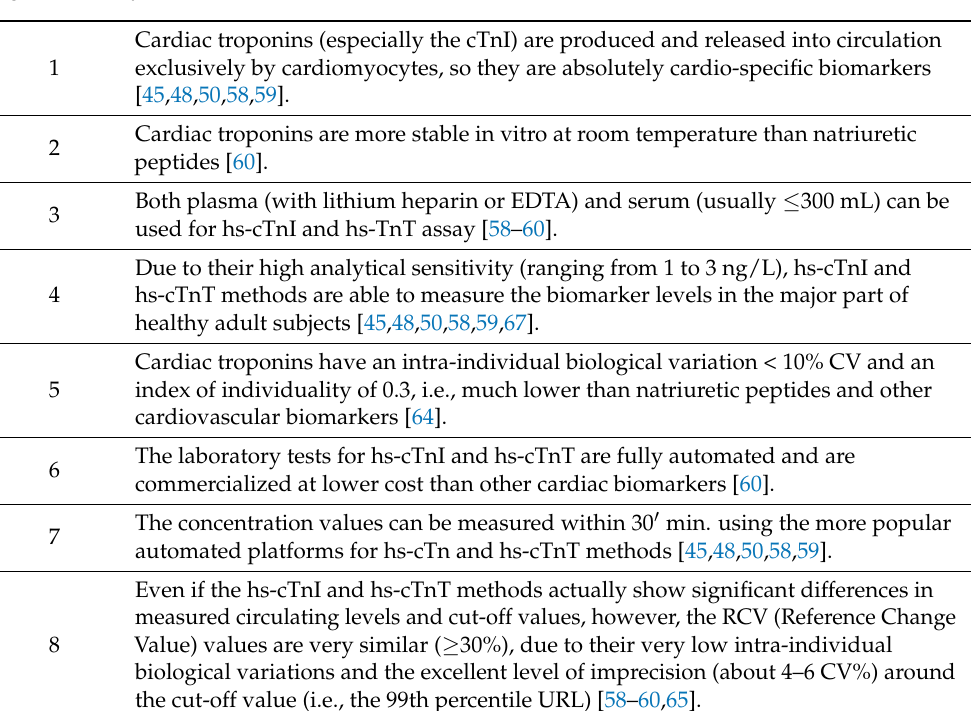
Table 1. Analytical and pathophysiological characteristics of cardiac troponins measured with high-sensitivity